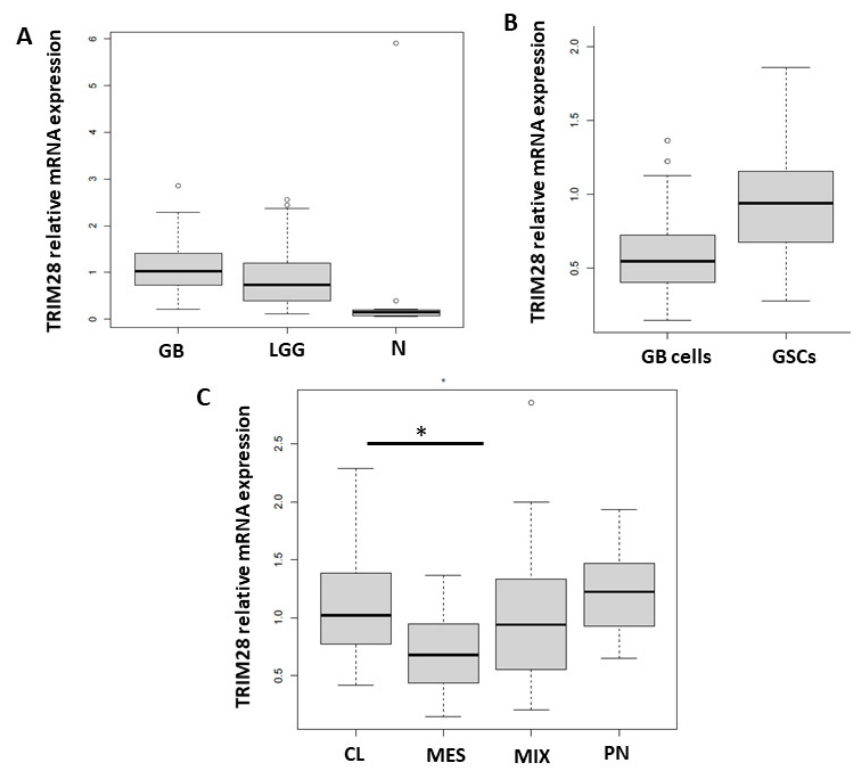
Figure 1. TRIM28 gene expression in glioma tissues, GB cells and GB tissue subtypes. TRIM28 mRNA expression levels were determined by RT-qPCR in ( A ) GB ( n = 95), LGG (glioma I–II, n = 19) and non-cancerous brain tissues (N, n = 16). ( B ) Primary differentiated GB cells (GB cells, n = 18) and GSCs ( n = 6), and ( C ) CL ( n = 24), PN ( n = 8), MES ( n = 4) and MIX ( n = 59) GB tissue subtypes. mRNA values were normalized to housekeeping genes HPRT1 and GAPDH and analysed with quantGenius software [41]. Statistical analysis was performed in R, using analysis of variance to determine the homogeneity of variance between glioma tissues, primary and stem cells, and subtypes. Tukey’s post hoc test was then used to for multiple comparison between groups with significance levels (* p < 0.05). Different Y -axis scales are